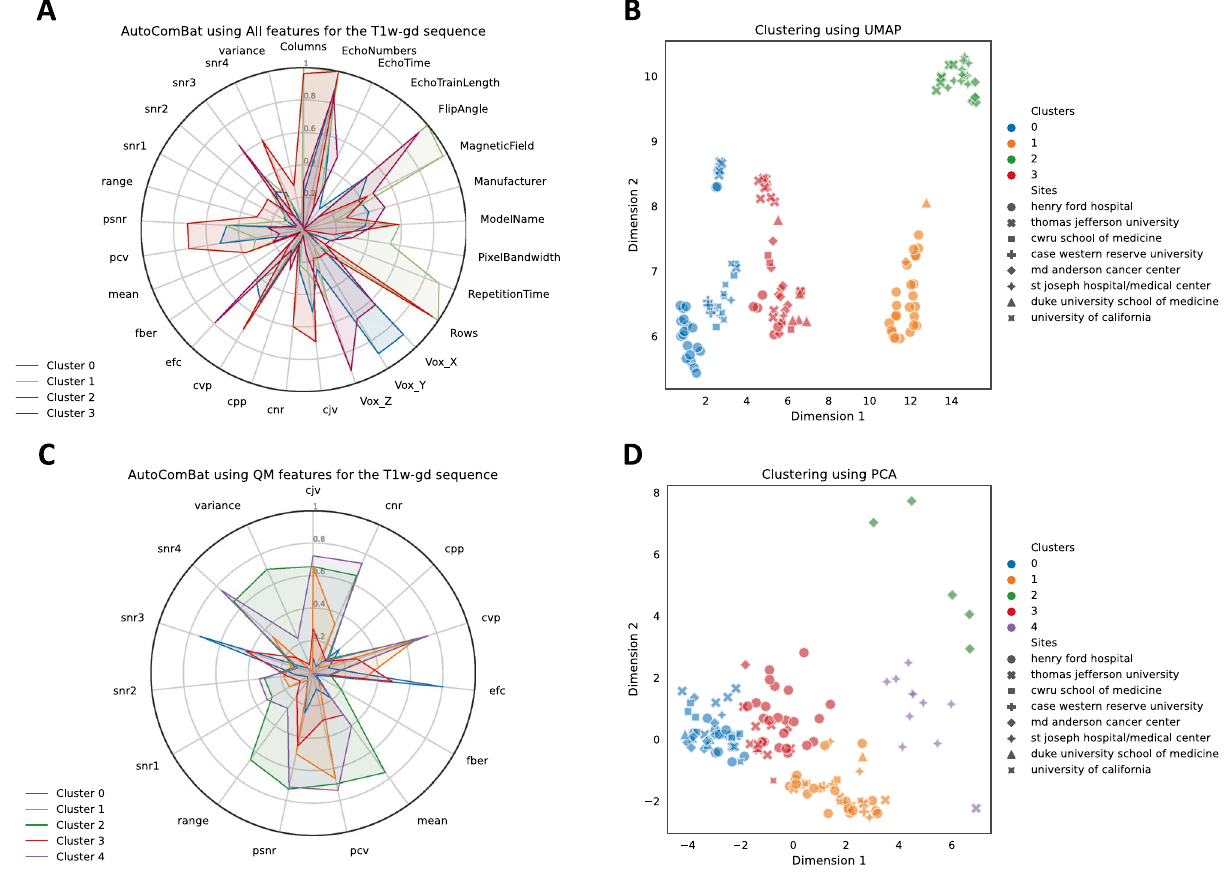
Figure 6. Clustering interpretation of AutoComBat for the T1w-gd images. ( A , C ) correspond to normalized feature importance in the final clusterings and ( B , D ) are visual representations of the proposed clusters. In both cases, a feature reduction strategy was retained in AutoComBat. ( A , B ) AutoComBat using all features as inputs - UMAP feature reduction, ( C , D ) AutoComBat using QM - PCA feature